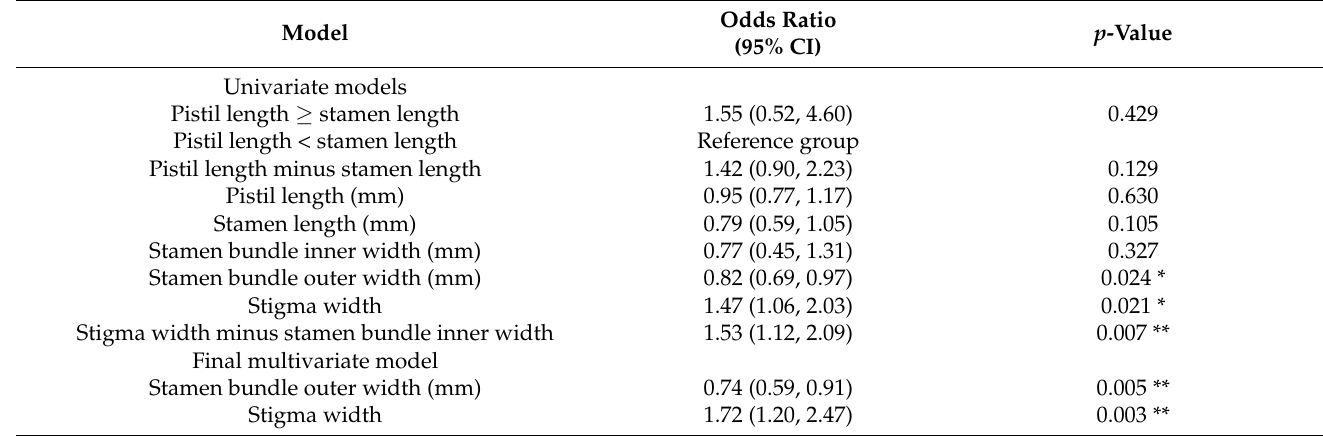
Table 4. Effects of phenotypic traits on the yield of tea varieties in 2013. Model